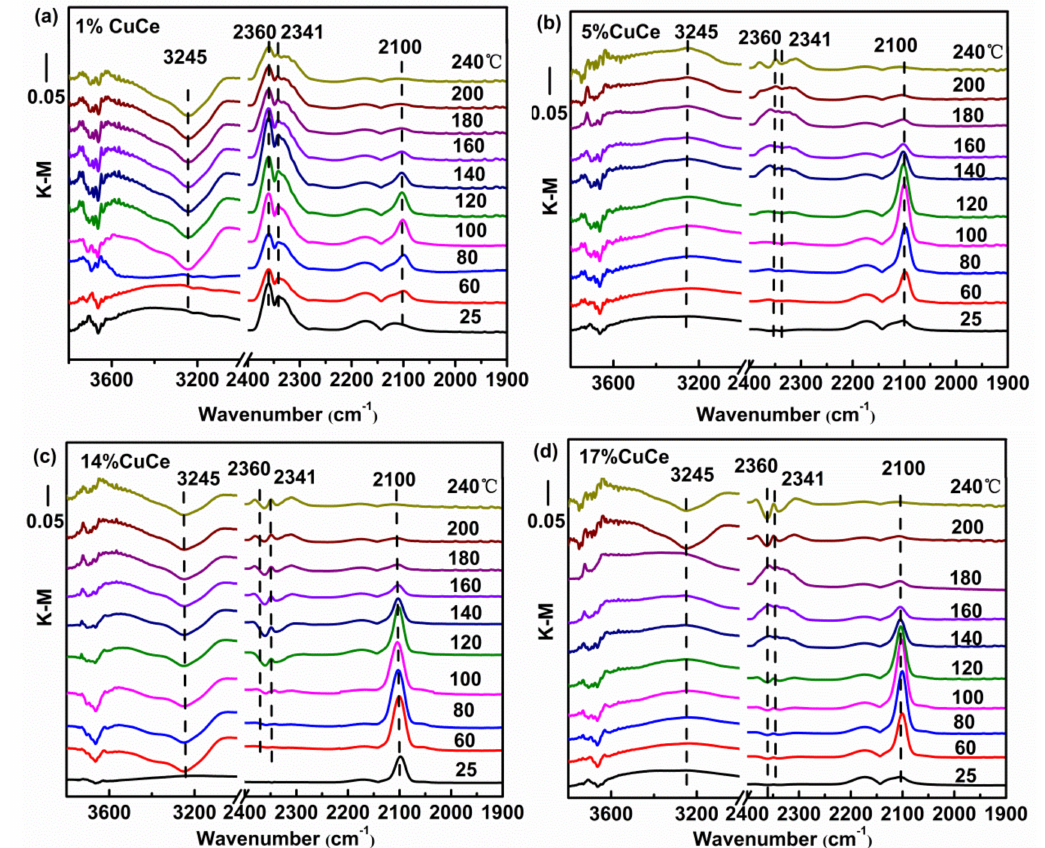
Figure 7. In situ DRIFTS spectra as a function of temperature from 25 to 240 ◦ C under operando CO conditions with representative samples: ( a ) 1% CuCe; ( b ) 5% CuCe; ( c ) 14% CuCe; ( d ) 17%